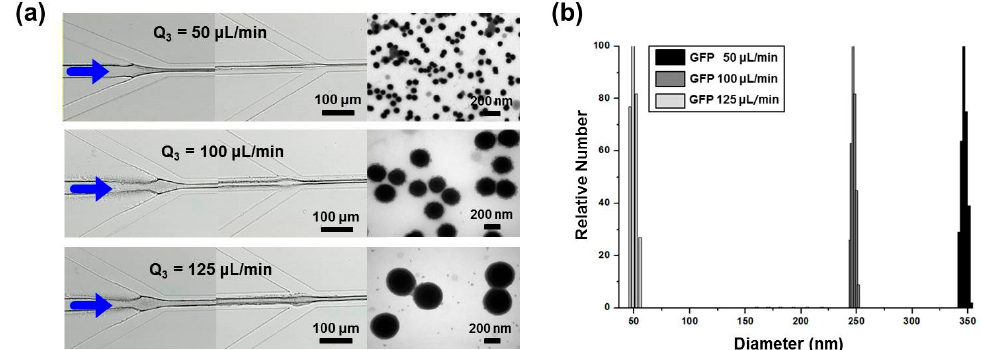
Figure 6. Measurement of the produced protein nanoparticles with different flow rates of GFP: ( a ) TEM images of the controlled particle size; ( b ) dynamic light scattering (DLS) measurement. Table 1. Size control of the protein nanoparticles by changing the flow rate of the His-GFP solution.